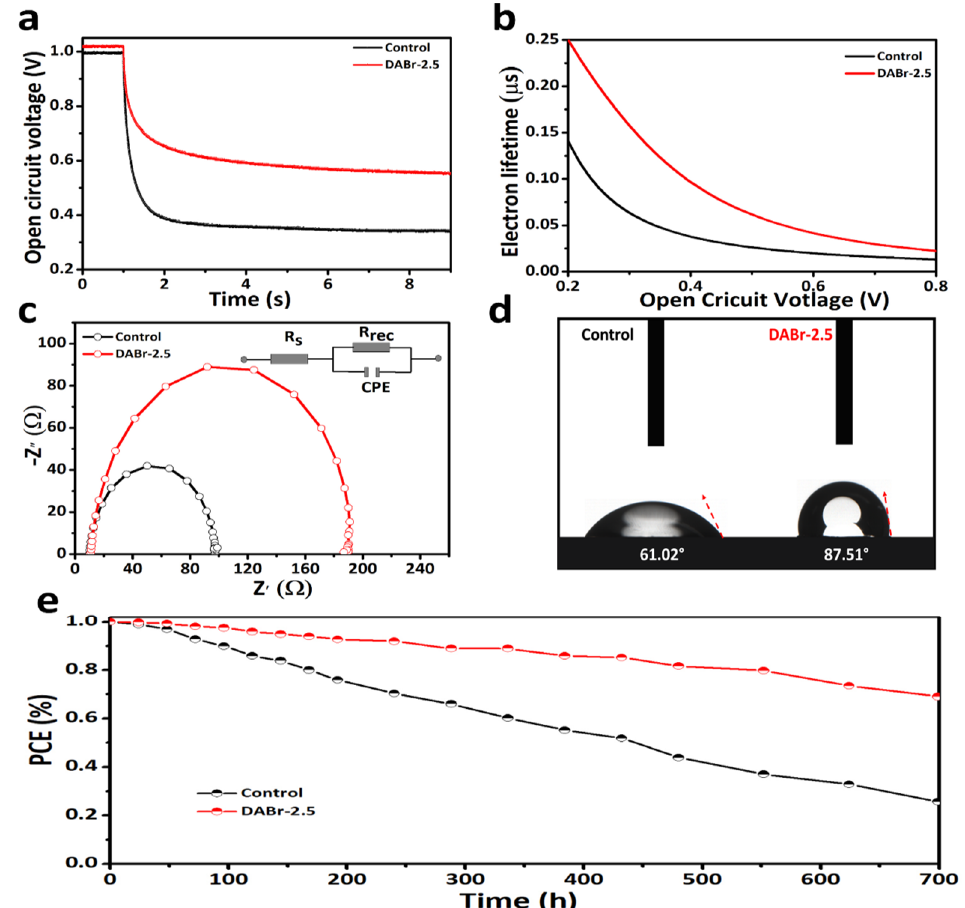
Figure 6. ( a ) Open − circuit voltage decay curves, ( b ) electron lifetimes curves ( c ) electrochemical impedance spectroscopy (EIS) curves of devices based on the control and DBAr − 2.5 − treated films. ( d ) Contact angle photographs of the control and DABr − 2.5 − treated films. ( e ) The normalized PCEs of the prepared devices aged for 700 h under 30% RH at 26 °C.